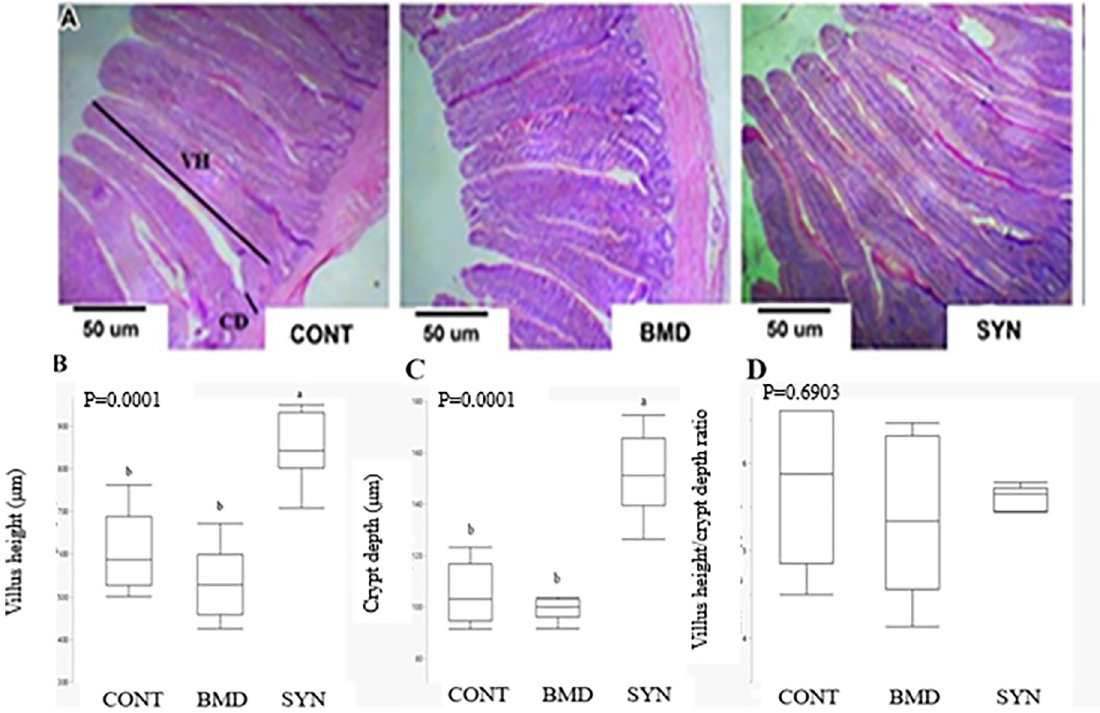
Fig 1. The examples of the morphological changes of the villus height and crypts depth in the jejunum of broiler chickens. Treatments: Heat stressed birds fed the basal diets (CONT), mixed antibiotic Bactiracin Methylene Disalicylate (BMD) or Synbiotic (SYN). VH: Villus height; CD: Crypt depth. The scale bar = 50